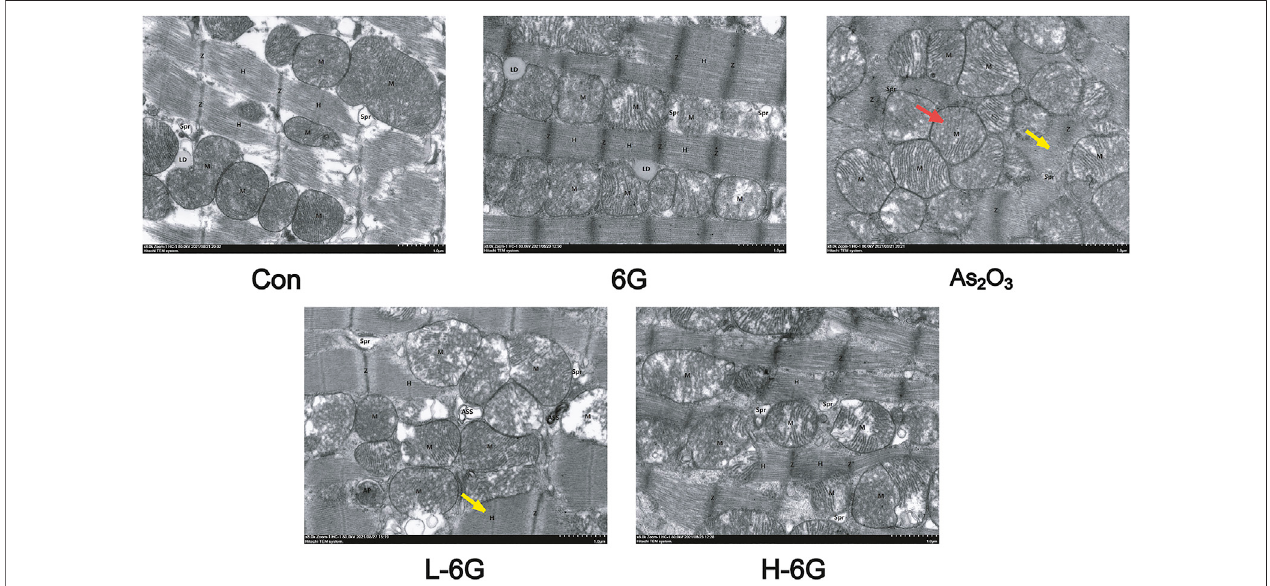
FIGURE 7 | Effect of 6G on the ultrastructure of cardiomyocytes. Representative TEM images show mitochondrial injury. Red arrows represent swelling of mitochondria and yellow arrows represent rupture of mitochondrial membranes. Scale bar = 500 nm.